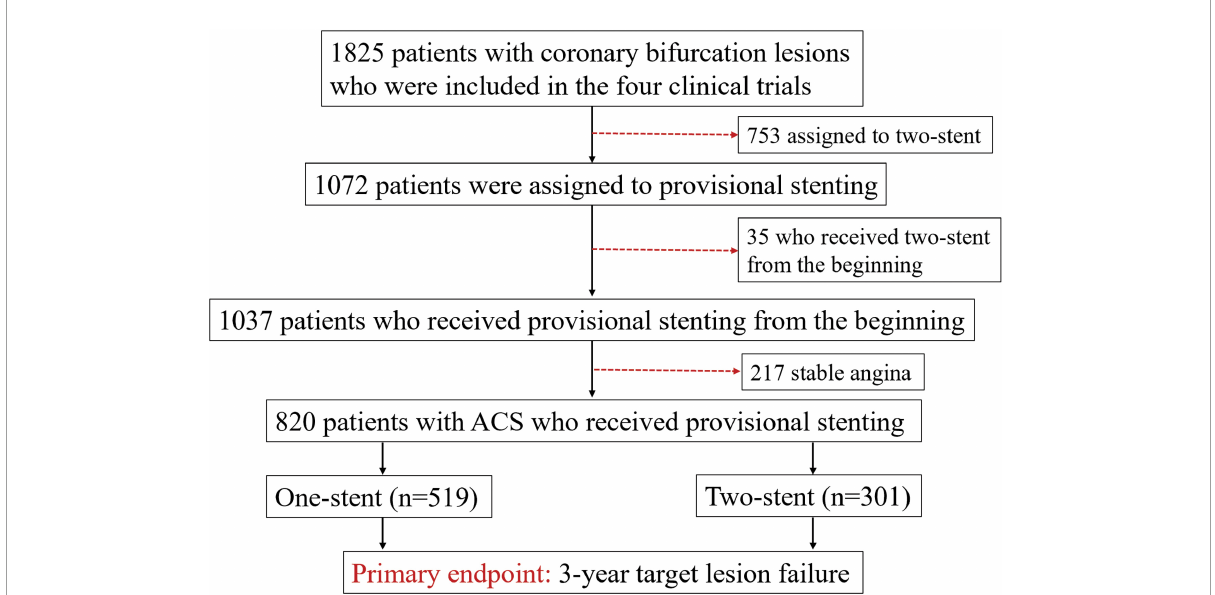
FIGURE1 Study flowchart. Description: 820 patients with acute coronary syndrome (ACS) were assigned to the provisional stenting (PS) with 1-stent and the PS with 2-stent groups.